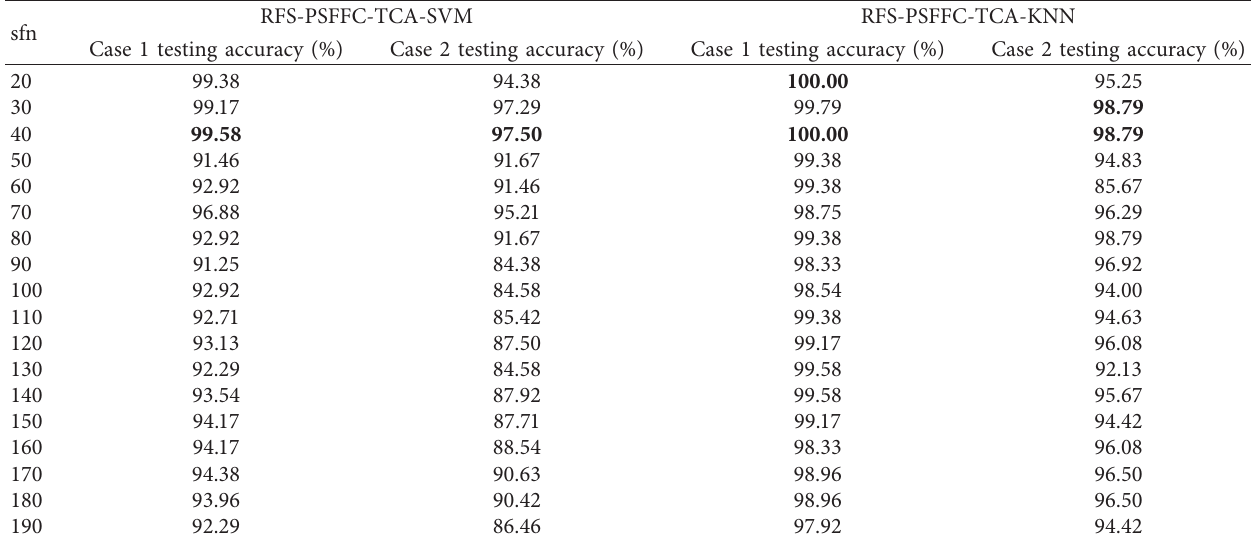
Table 11: The testing accuracies of RFS-PSFFC-TCA-SVM and RFS-PSFFC-TCA-KNN (the dimension size is 20).